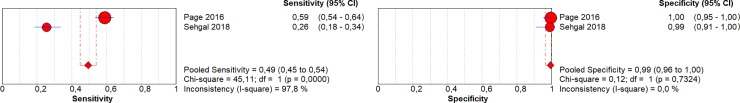
Forest plot of sensitivity (A), specificity (B), and heterogeneity from the DID and/or CIE test for the subgroup analyses (two studies with commercial tests).